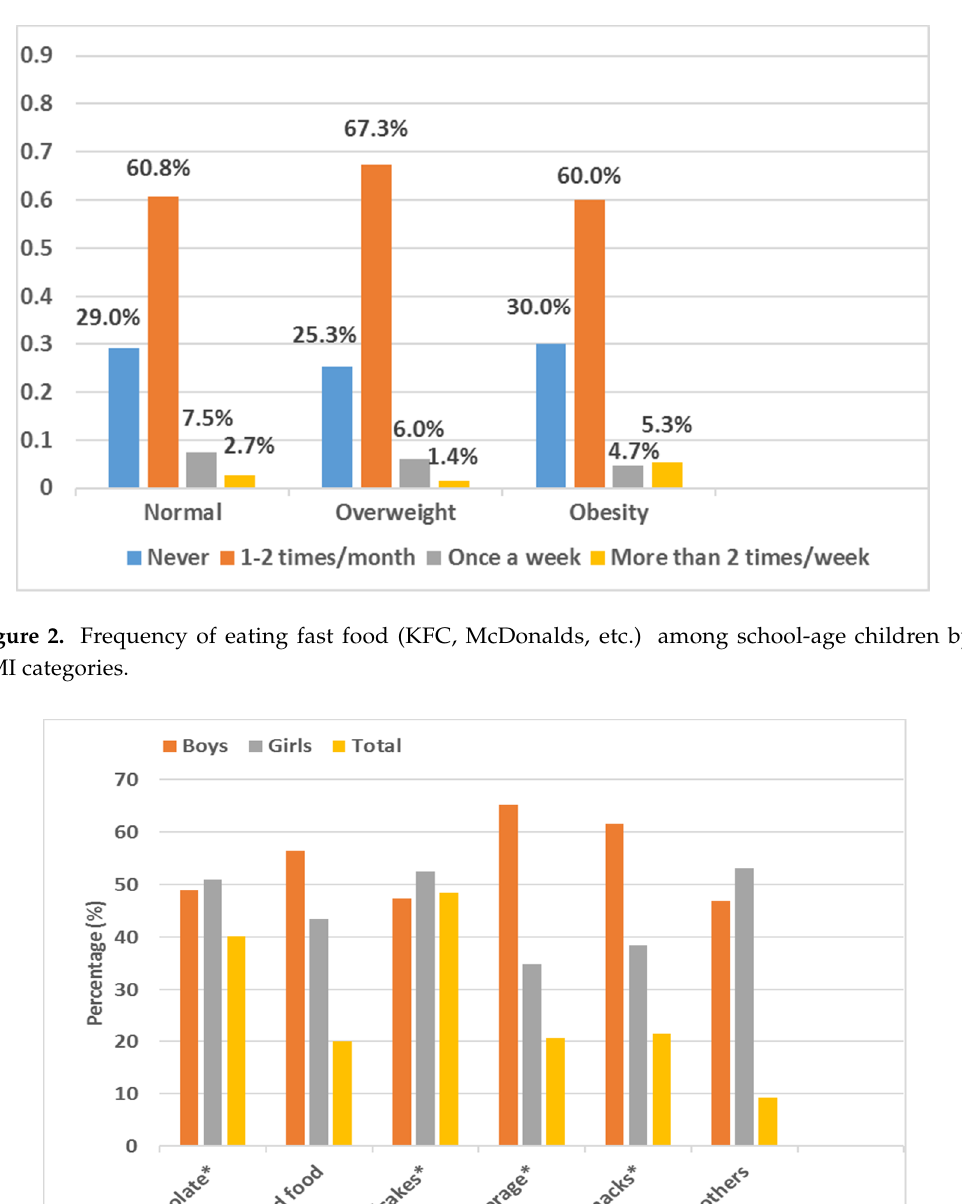
Figure 2. Frequency of eating fast food (KFC, McDonalds, etc.) among school-age children by BMI categories.